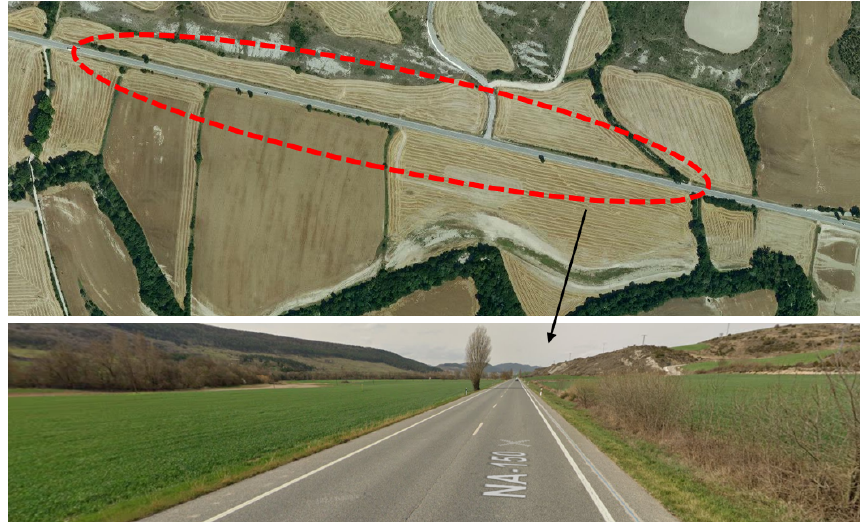
Figure 6. Section of the road used for traffic measurements. ©2023 Google, CNES/Airbus, Gobierno de Navarra-Instituto Geográfico Nacional de España, Maxar